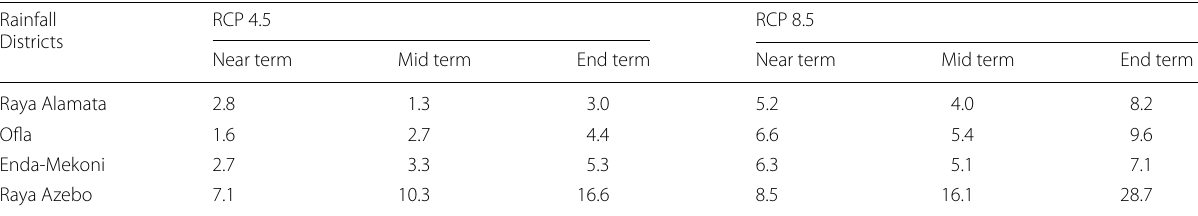
Table 4 Changes in annual rainfall (%) compared to the baseline over four districts in RCP 4.5 & RCP 8.5 Rainfall RCP Districts